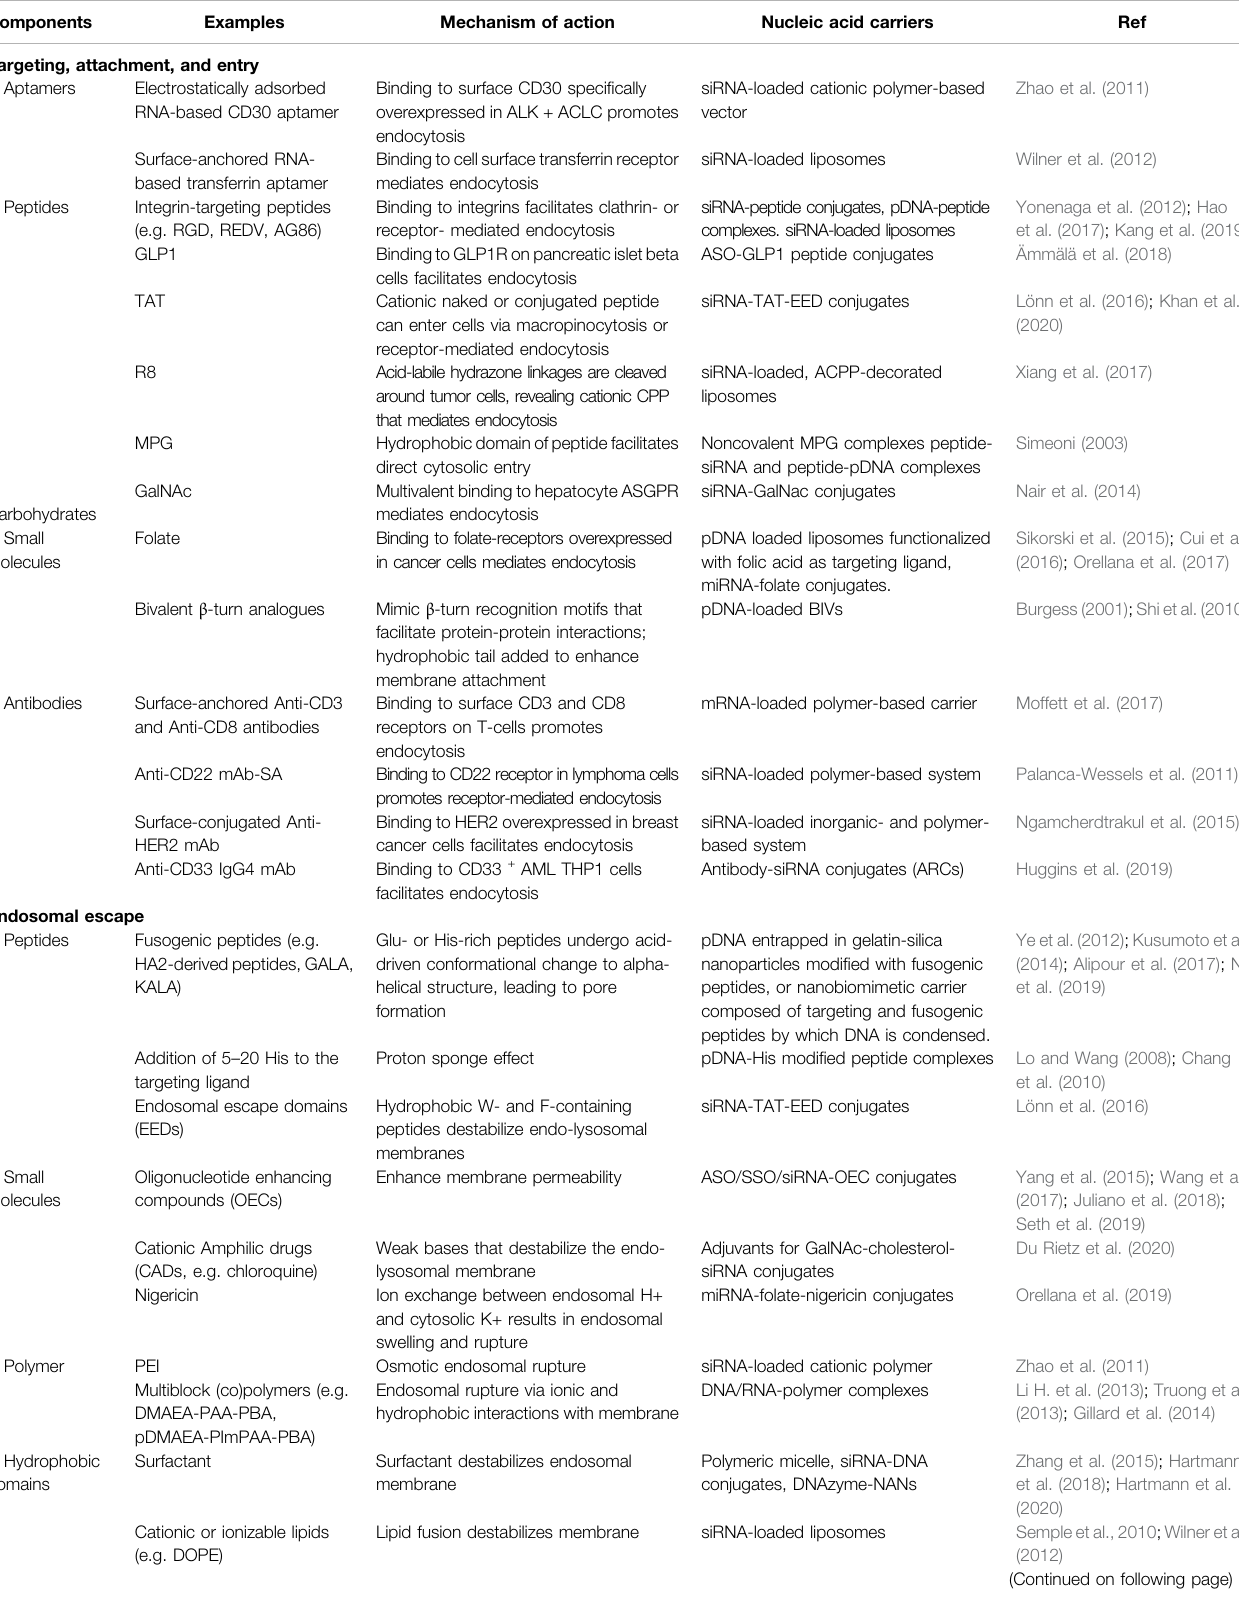
TABLE 2 | Key components added to modulate traf fi